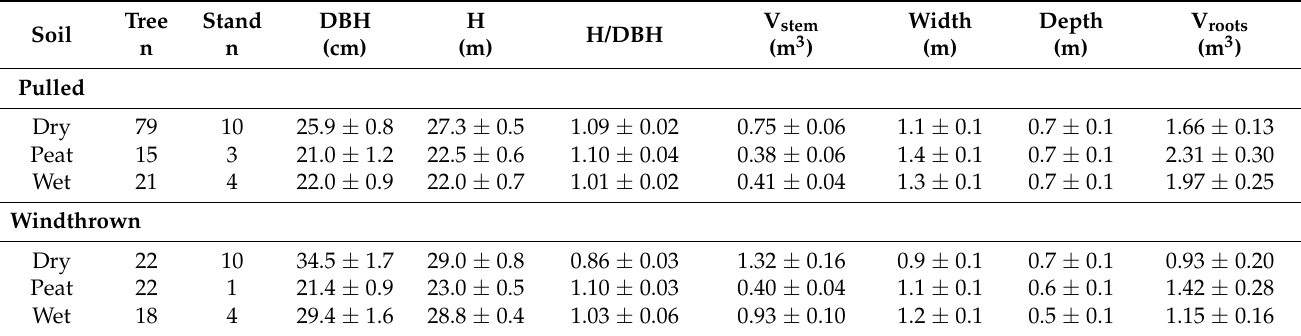
Table 3. Tree (Tree n) and stand number (Stand n); mean ( ± standard error) stem diameter at breast height (DBH); height (H), ratio of height, and stem diameter at breast height (H/DBH); stemwood volume (V stem ); depth, width, and volume (V roots ) of soil–root plate of pulled and windthrown East- ern Baltic silver birches on freely draining mineral, drained deep peat, and periodically waterlogged mineral